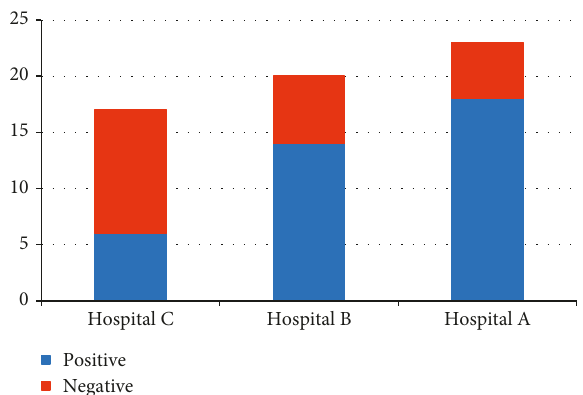
Figure 1: Bacterial frequency in collected samples from cell phones in selected